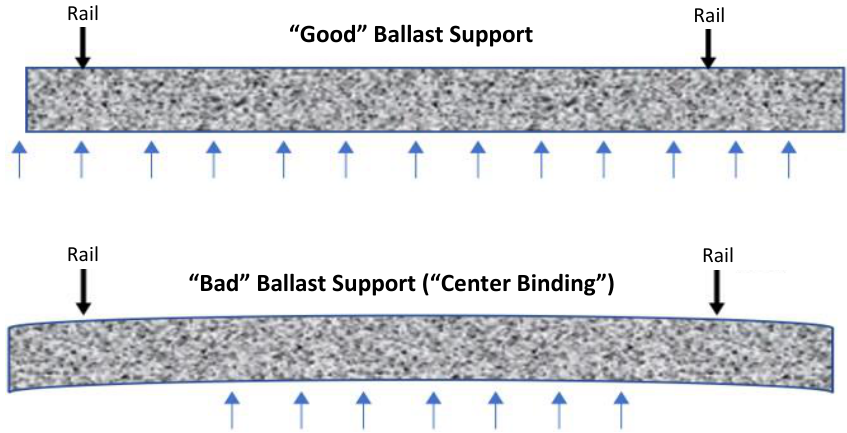
Figure 1. Deflected shape profiles for good and bad ballast support conditions.